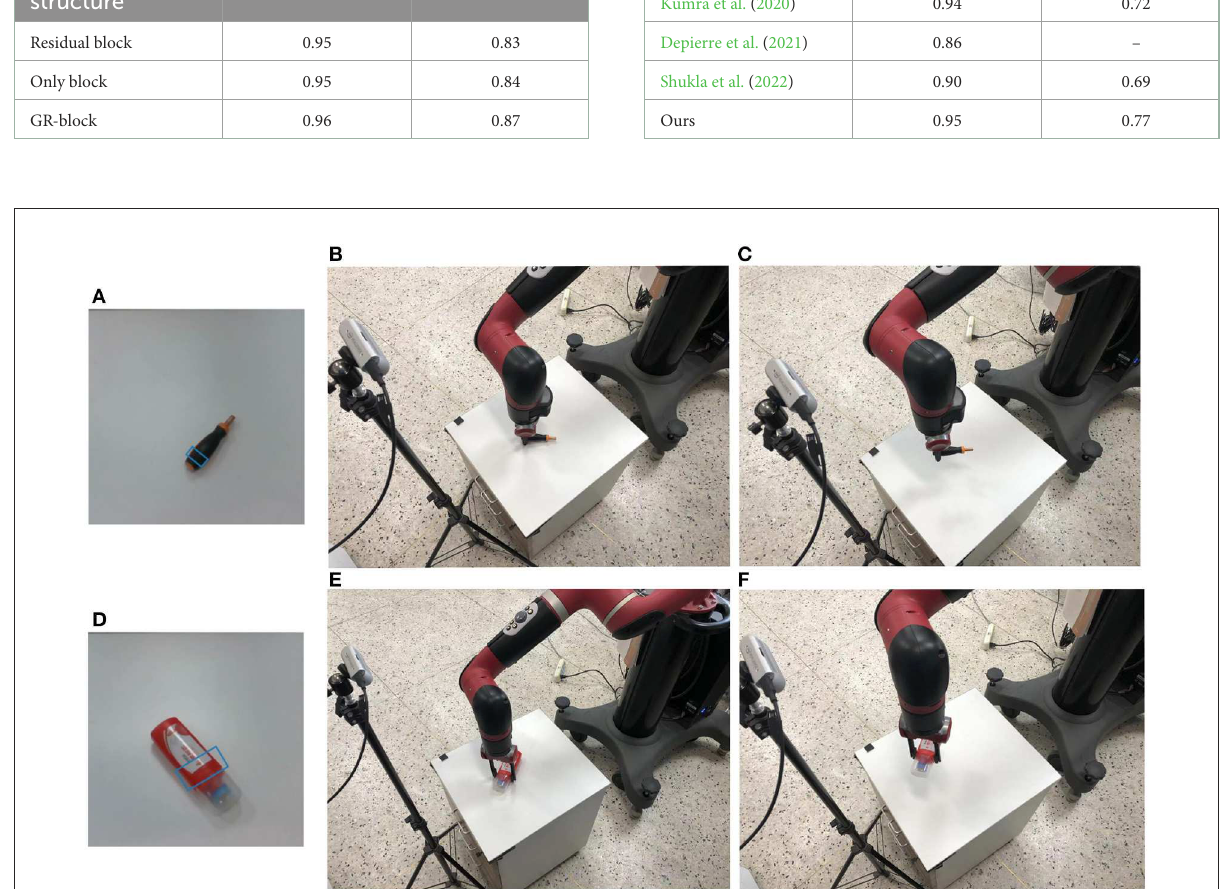
TABLE 2 Ablation study. Network structure